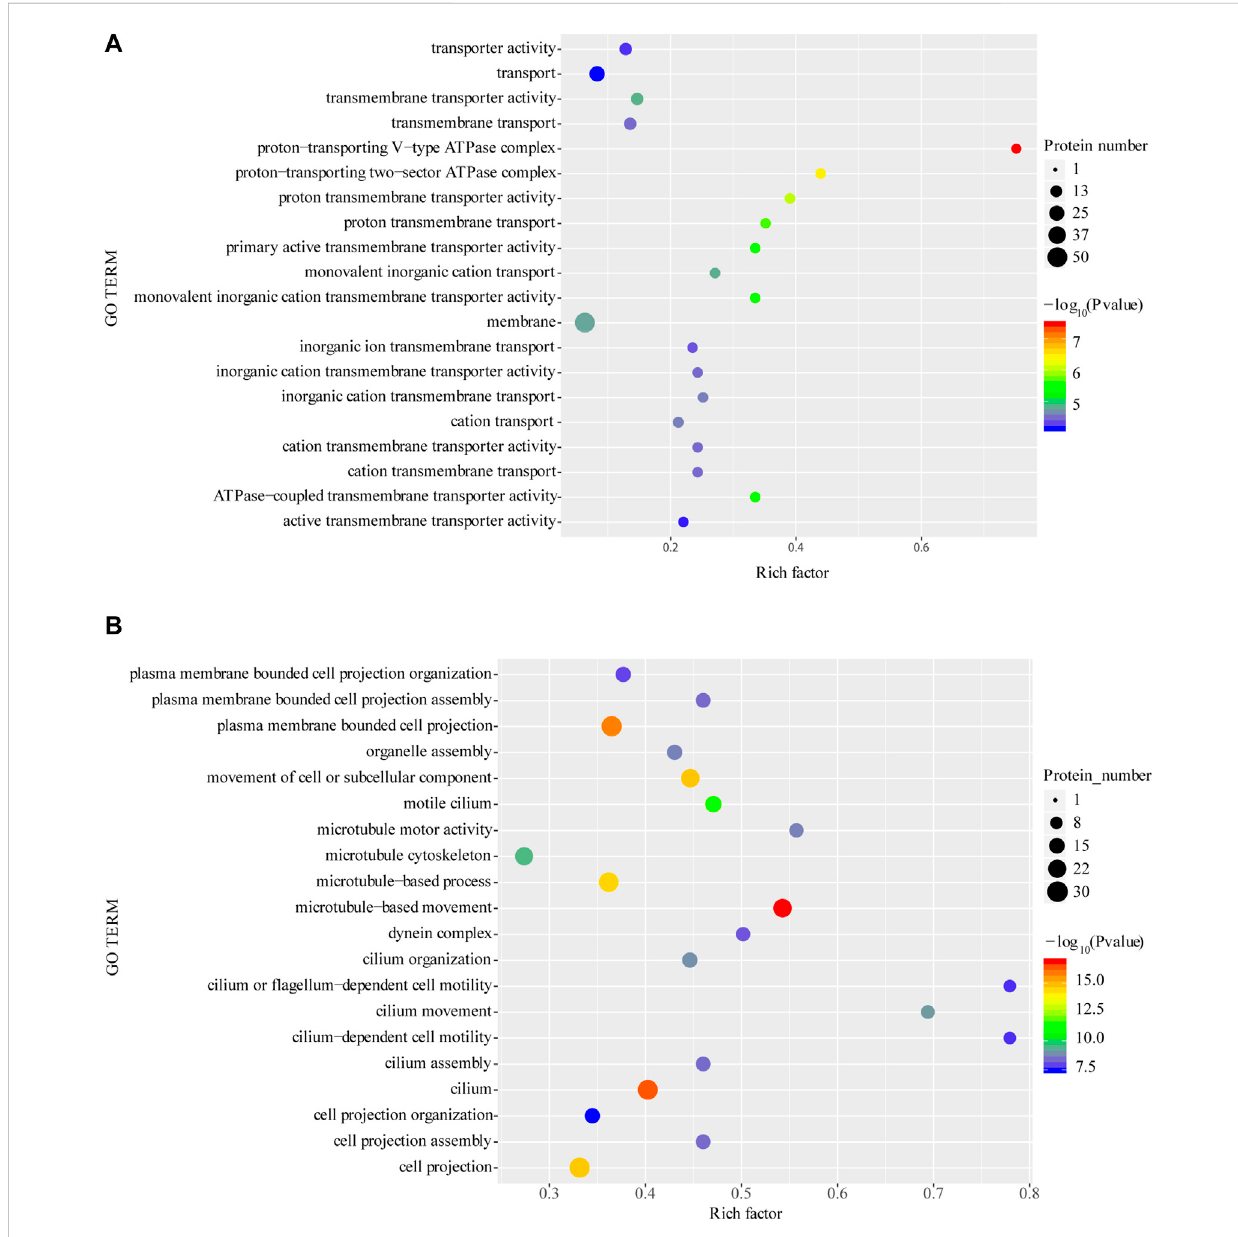
FIGURE 4 Enrichment of GO function of upregulated proteins (A) and downregulated proteins (B) . * p < 0.05 or ** p < 0.01 versus starvation group.